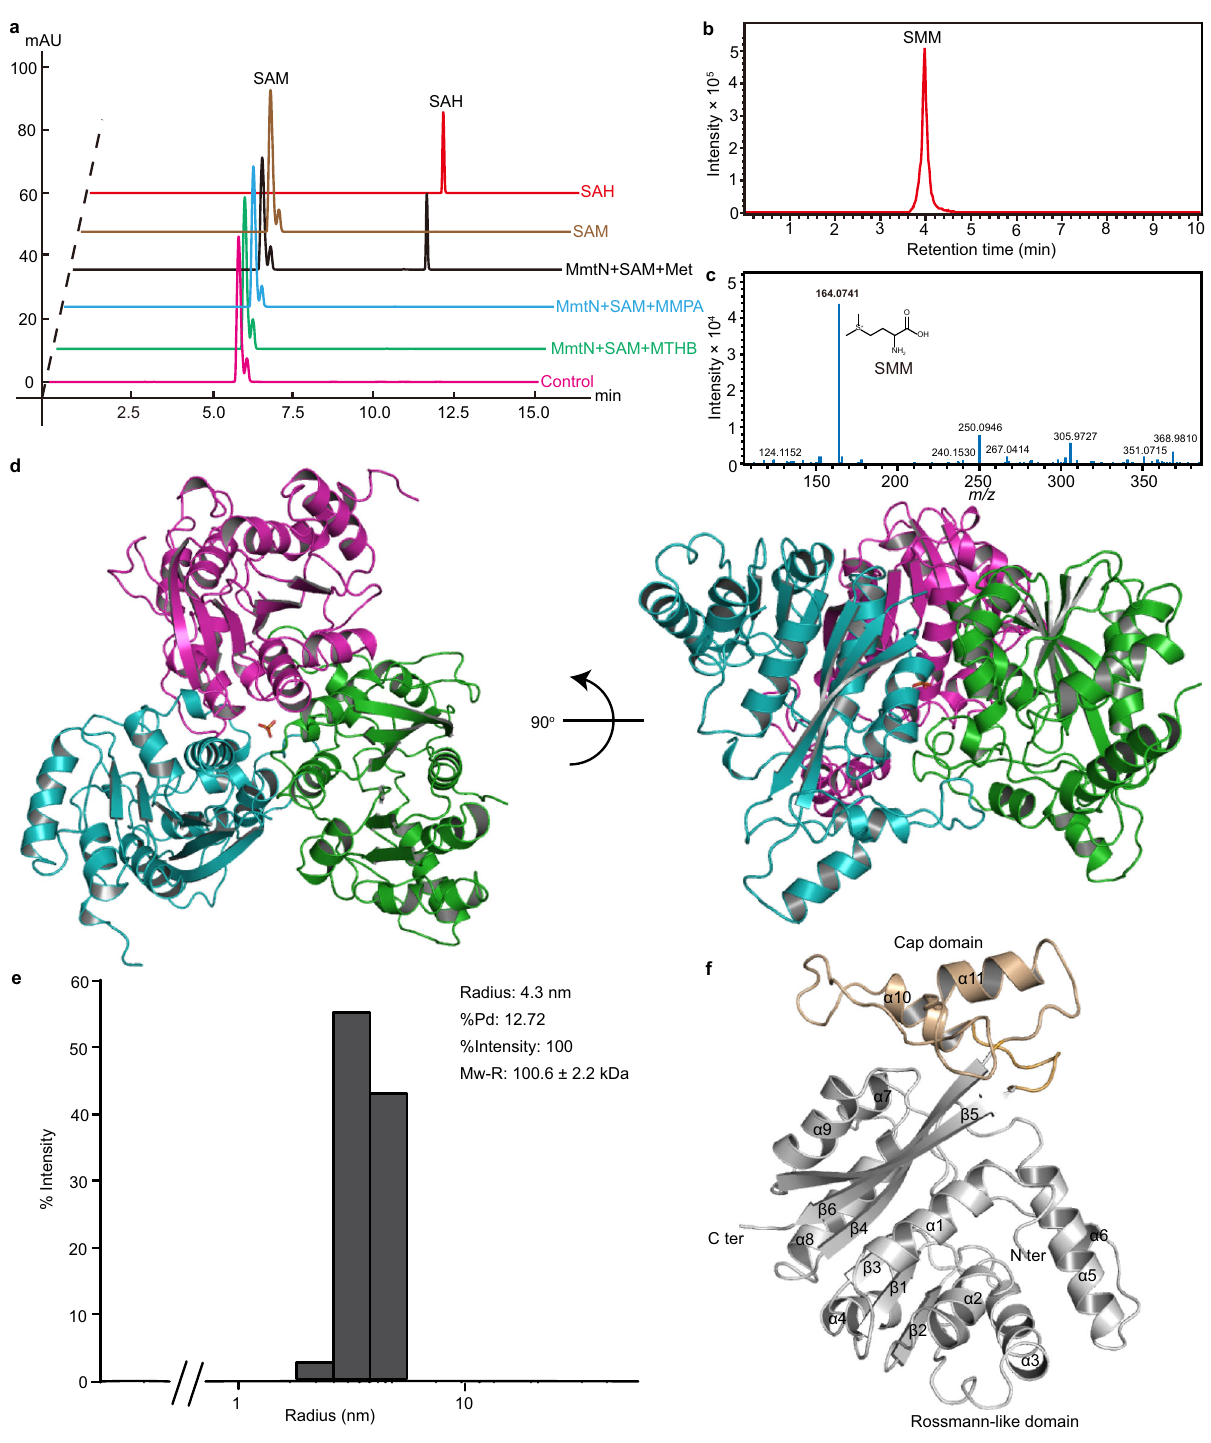
Fig. 2 Characterization and overall structural analyses of MmtN from R. indicus B108. a The substrate speci fi city of R. indicus B108 MmtN. Detection of the methylation activities of R. indicus B108 MmtN towards MTHB, MMPA, and Met by HPLC at 260 nm. The reaction system without MmtN was used as the control. The data shown are representatives of triplicate experiments. b A total ion chromatogram (TIC) of SMM (extracted m/z = 164) produced by SAM-dependent MmtN S -methylation of Met via LC – MS. The data shown are representatives of triplicate experiments. c The mass spectra of SMM produced by SAM-dependent MmtN S -methylation of Met via LC – MS. The data shown are representatives of triplicate experiments. d The overall structure of MmtN. There are three MmtN molecules arranged as a trimer in an asymmetric unit. The three MmtN molecules are colored in magenta, green and cyan, respectively. The PO 4 3- in MmtN is shown as orange sticks. e DLS analysis showing MmtN to have a molecular mass of 100.6 kDa in solution, indicating that MmtN maintains a trimer. The data shown are representatives of triplicate experiments. f The structure of an MmtN monomer. The cap domain is colored in orange and the rossmann-like domain in grey. Source data are provided as a Source Data fi